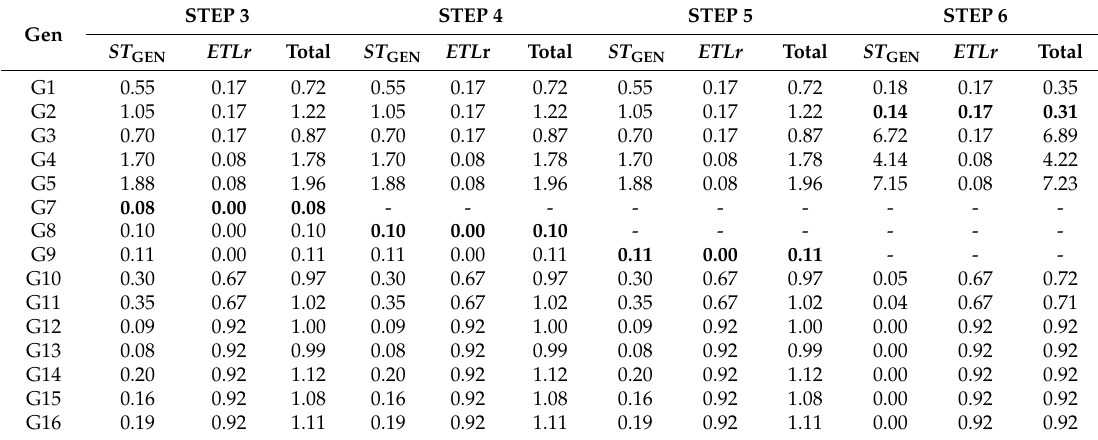
Table 2. Example of the generator start-up sequence of the eastern regions.